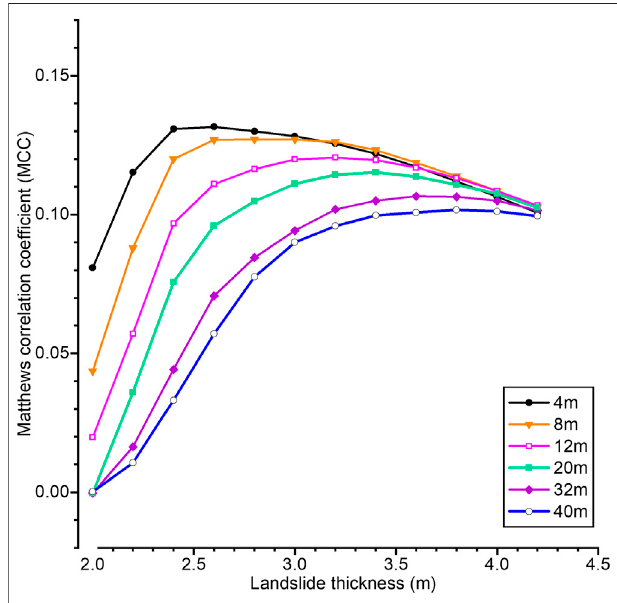
FIGURE 6 | Matthews correlation coef fi cient for various DEM cell sizes (4 – 40 m) and assumed landslide